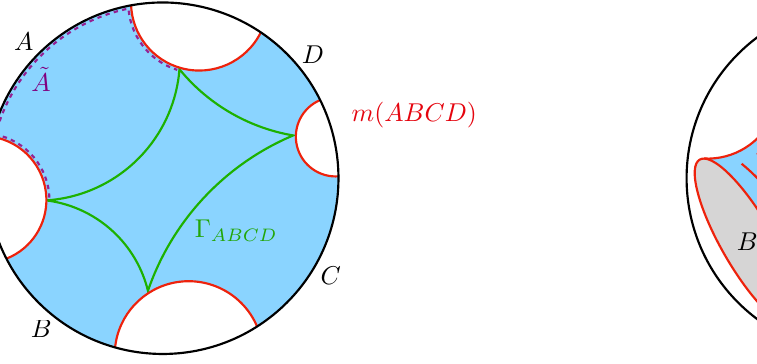
Figure 1 . The Cauchy surface Σ with entanglement wedge (blue) bounded by the given RT surface (red) and containing the multipartite entanglement wedge cross section (green) for: [Left] n = 4 boundary regions and d = 2 , with the part of the partition of ∂W ABCD that contains A , denoted ˜ A , additionally shown in dashed purple. [Right] n = 3 boundary regions A , B , and C in a CFT of spacetime dimension d = 3